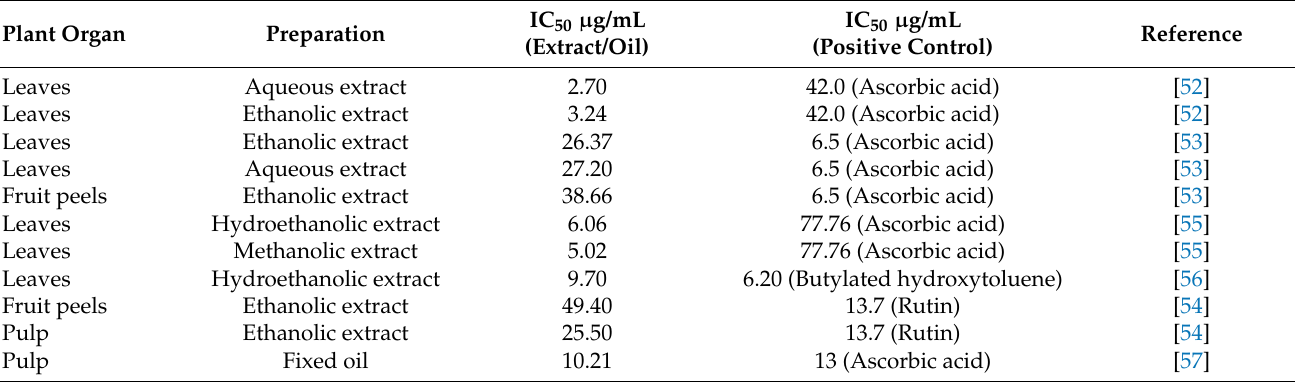
Table 1. In vitro antioxidant activity of Cariocar coriaceum using the free radical DPPH (2,2-difenil-1-